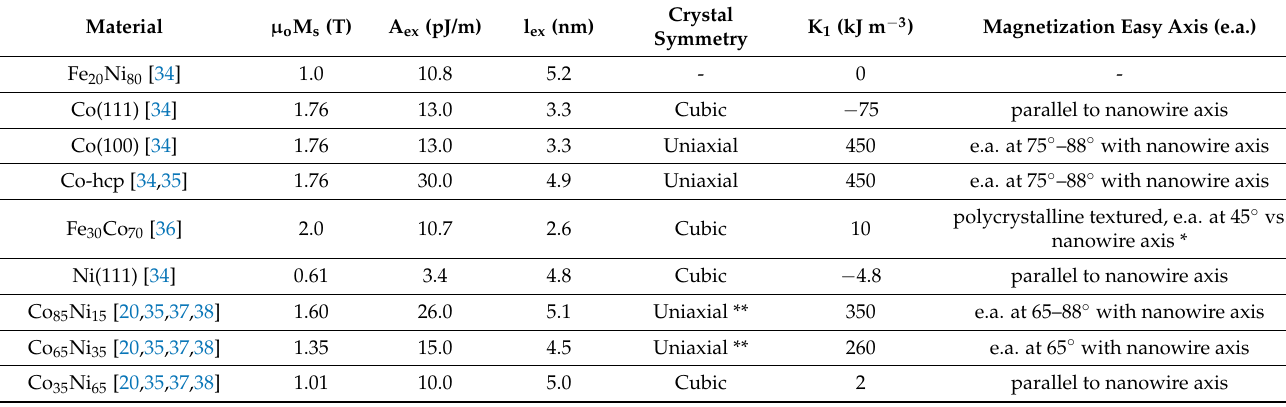
Table 2. Materials parameters used in micromagnetic modeling: saturation magnetization, µ o M s , exchange stiffness, A ex , exchange-correlation length, l ex = (2A ex / µ oMs 2 ) 1/2 , crystalline symmetry, first magnetocrystalline anisotropy constant, K 1 , and the direction of the magnetization easy axis with respect to the nanowire axis. Saturation magnetization and exchange stiffness for CoNi alloys have been obtained by linear interpolation with the Co content of the alloy